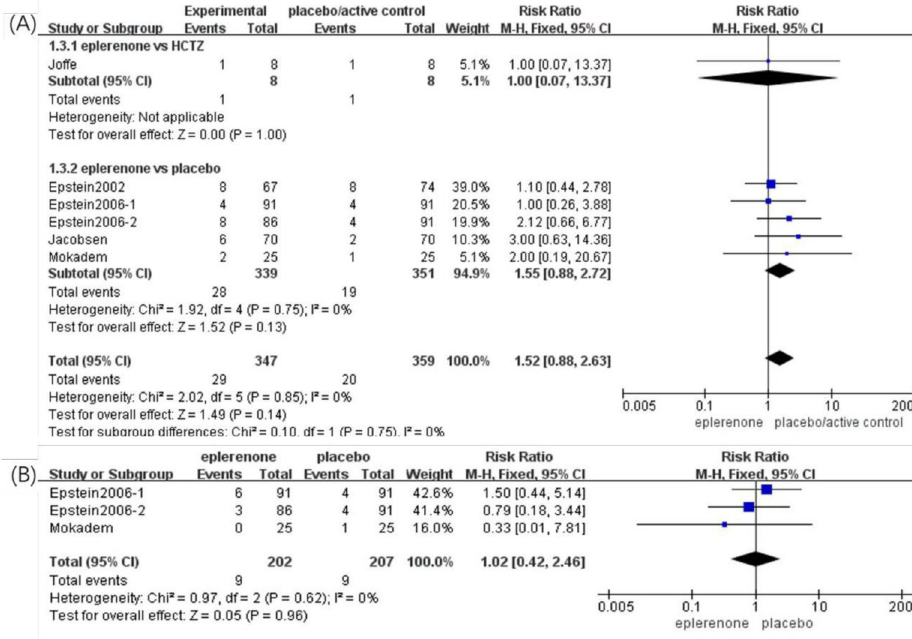
Fig 7. Forest plots of the effects between the eplerenone treatment groups and the controls. (A) Incidence of hyperkalemia in articles comparing eplerenone to placebo/active control. (B) Incidence of the adverse events of cough in articles comparing eplerenone to placebo control. The black diamond represents summary data centred on the pooled estimates with the risk ratio, and the width spans the corresponding 95% CIs.